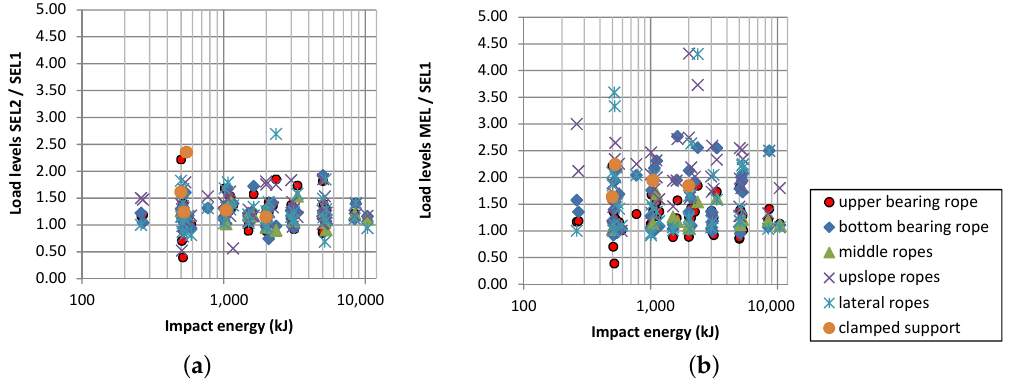
Figure 14. Maximum measured forces during ( a ) SEL2 and ( b ) MEL relative to the load measured during SEL1 with respect to the impact energy classes (energy class >4500 expanded to show effective impact